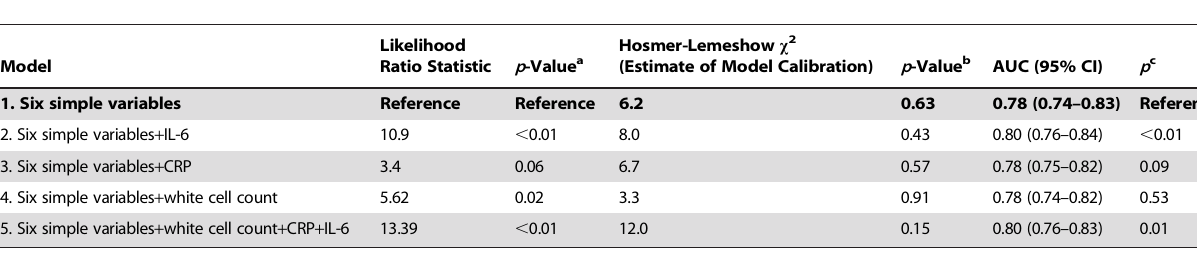
Table 3. Performance of models to predict poor outcome after stroke.